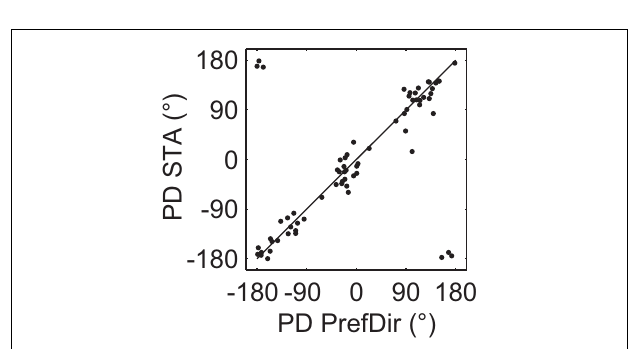
FIGURE 6 | Confirmation of multiple preferred directions. (A) A close-up of the RF of the same neuron shown in Figure 3A (for a color legend, see Figure 1F ).The two highlighted rectangles indicate the two regions of the RF where direction tuning was mapped with a single moving dot. (B) Polar direction tuning plots for single moving dots. Direction of stimulus motion is represented as the polar angle, firing rate as the radius.The maximum firing rate was 16 spikes per second.The green (blue) curve refers to the response to a single dot moving within the green (blue) highlighted patch of (A) .The red circle represents the response of the neuron during steady fixation of a